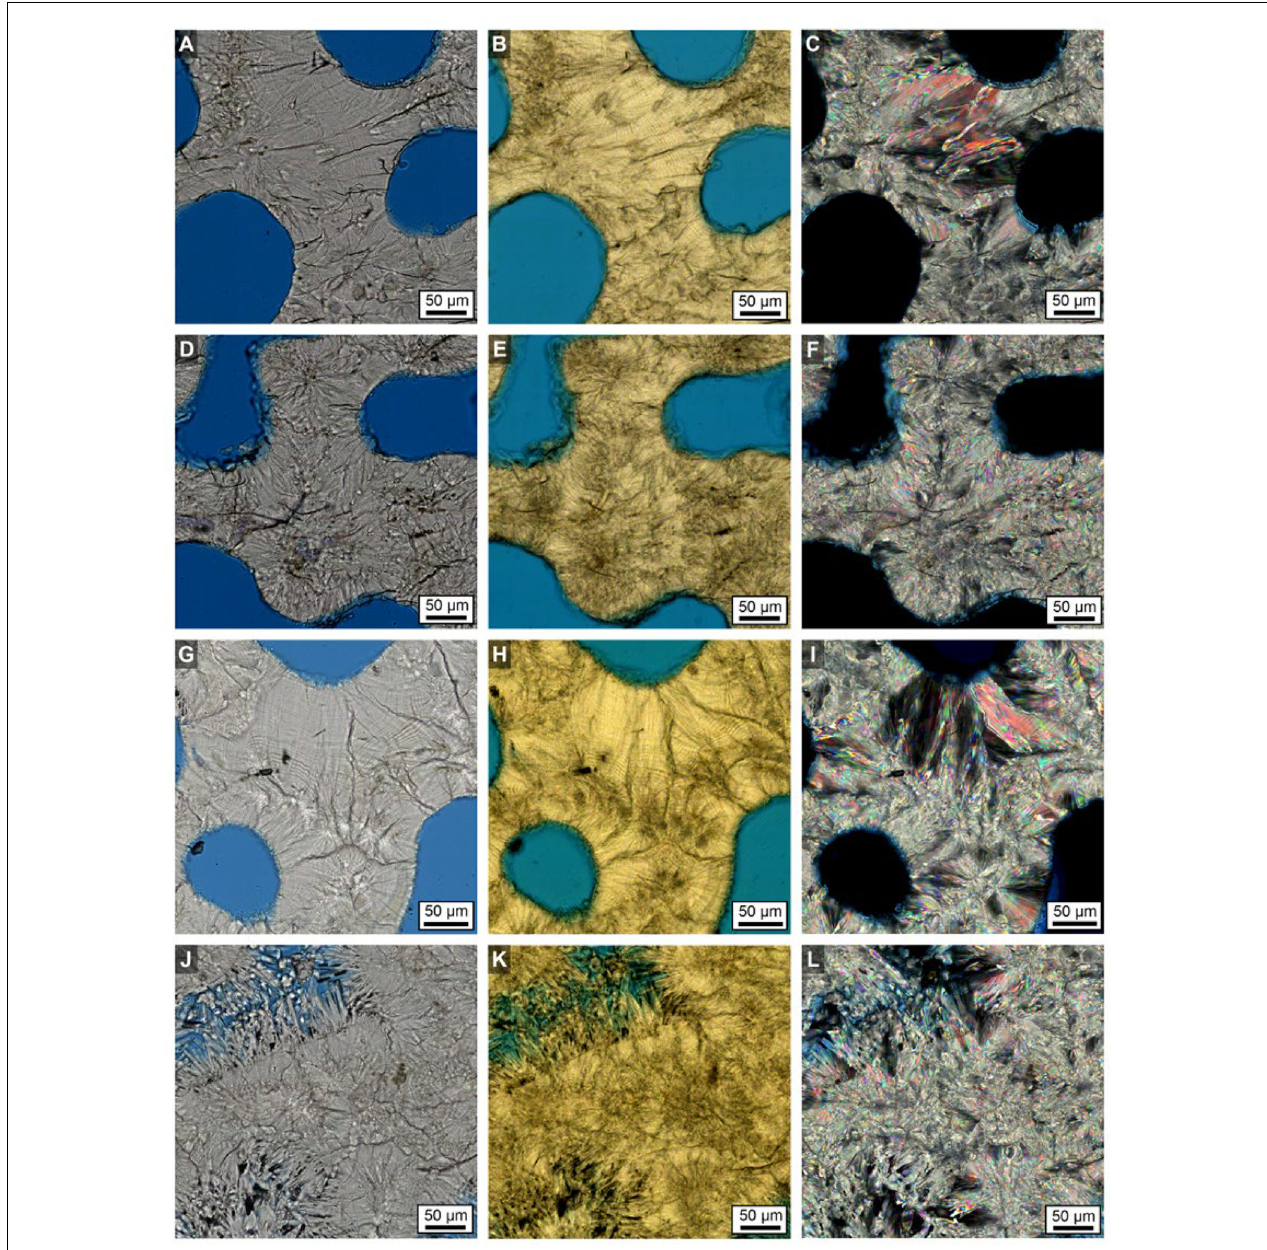
FIGURE 10 | Examples of brightfield (BF; A, D, G, J ), ring aperture contrast (RAC; B, E, H, K ) and polarization (POL; C, F, I, L ) imaging of the crystalline structure of Porites original and diagenetically altered skeletons in Core 3. (A–C) LDBs in the top 2 cm. (D–F) HDBs in the top 2 cm. (G–I) LDBs in the bottom 6 cm. (J–L) HDBs in the bottom 6